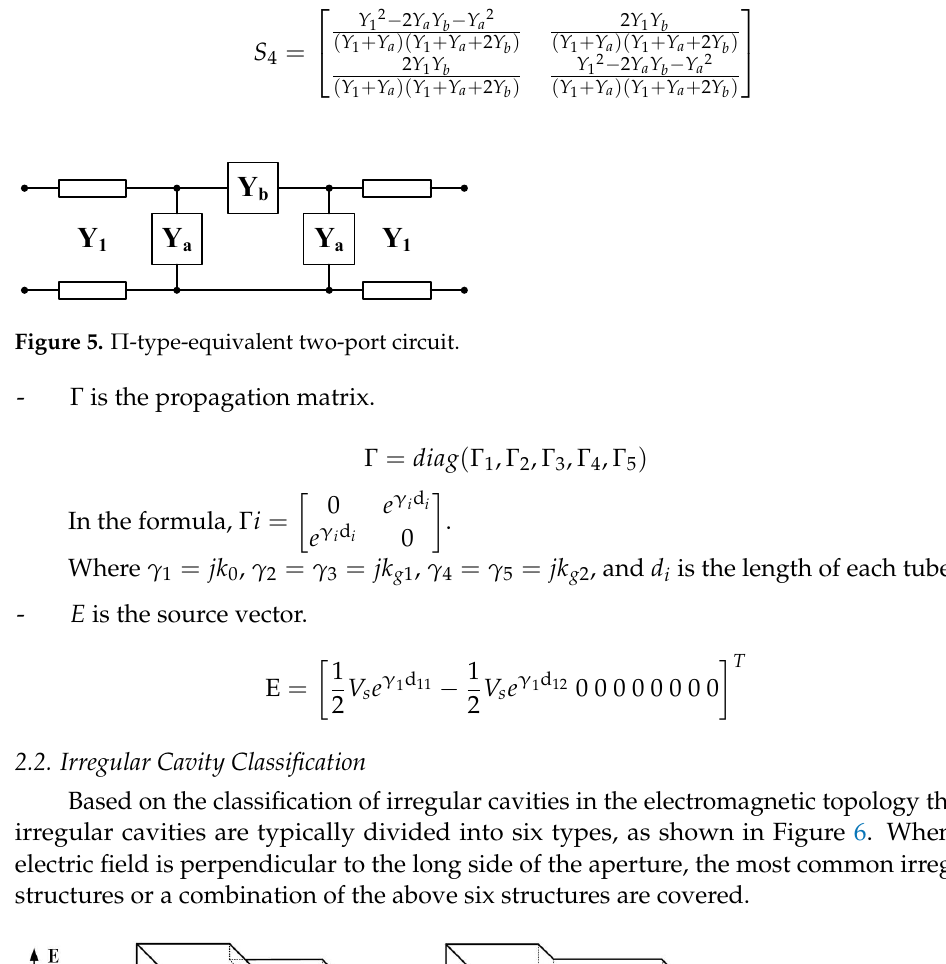
Capacitive obstacles with zero thickness, ( d ) Inductive obstacles with zero thickness, ( e ) Capacitive